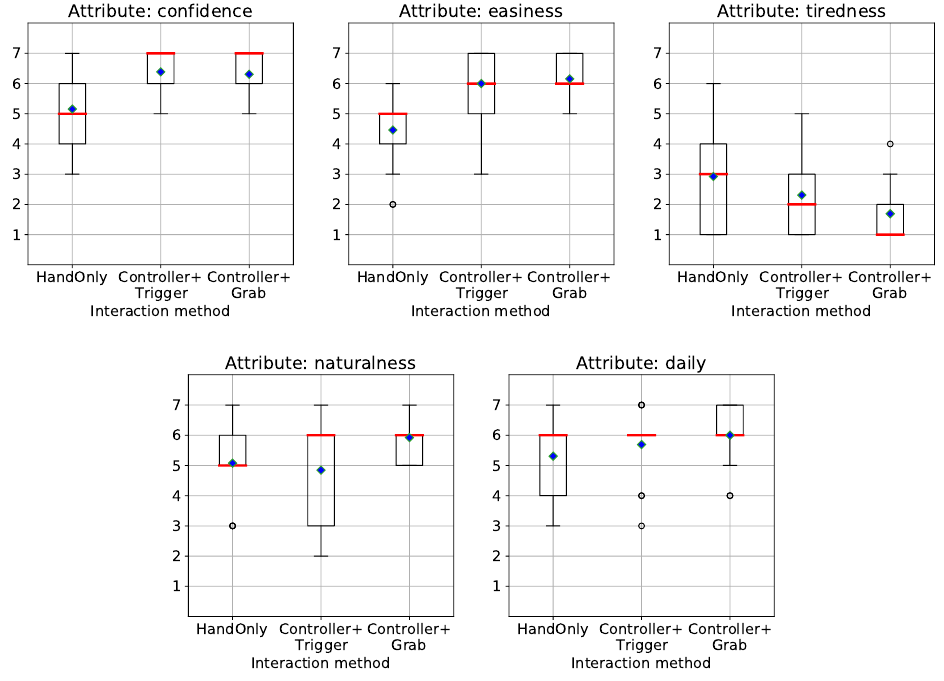
Figure 5. The distributions of the subjective ratings for different attributes.